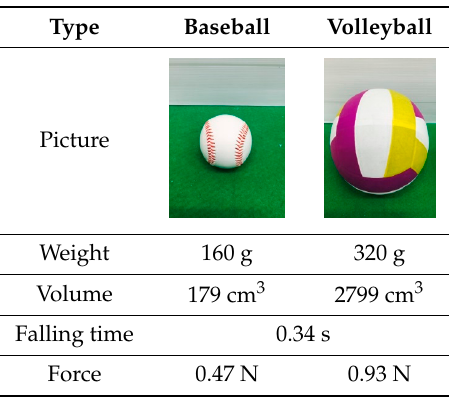
Figure 12. Two experimental states: ( a ) Ball is released, and ( b ) ball is raised to 45°. Table 3. Descriptions of the two balls. Table 4. Descriptions of the two balls.